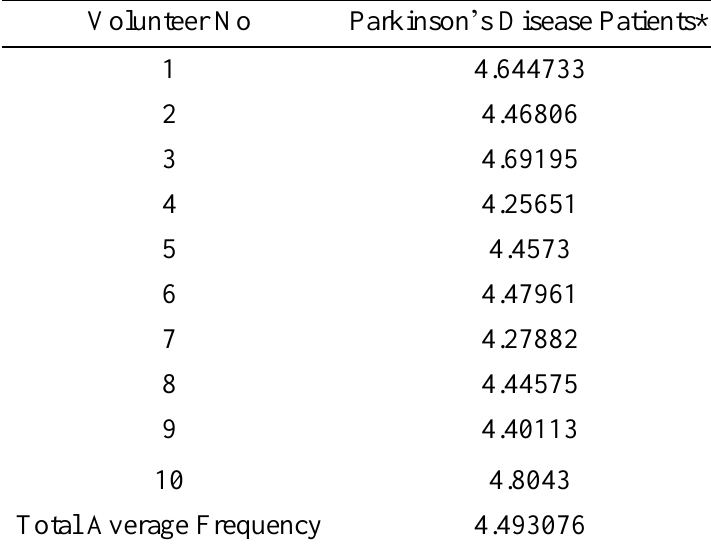
Table 6. Dorsum manus resting tremor frequency of Parkinson’s